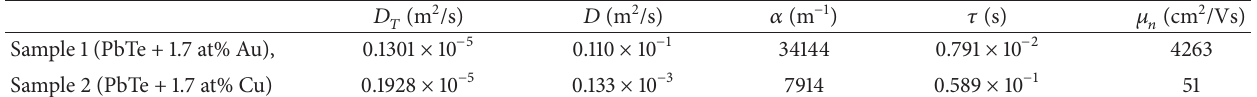
Table 4: Fitted photoacoustic parameters for PbTe doped with 1.7 at% Au or Cu.